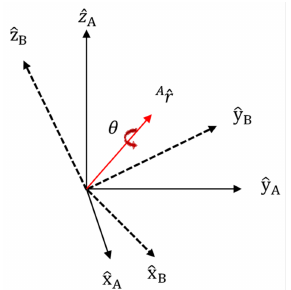
Figure 5. Quaternion